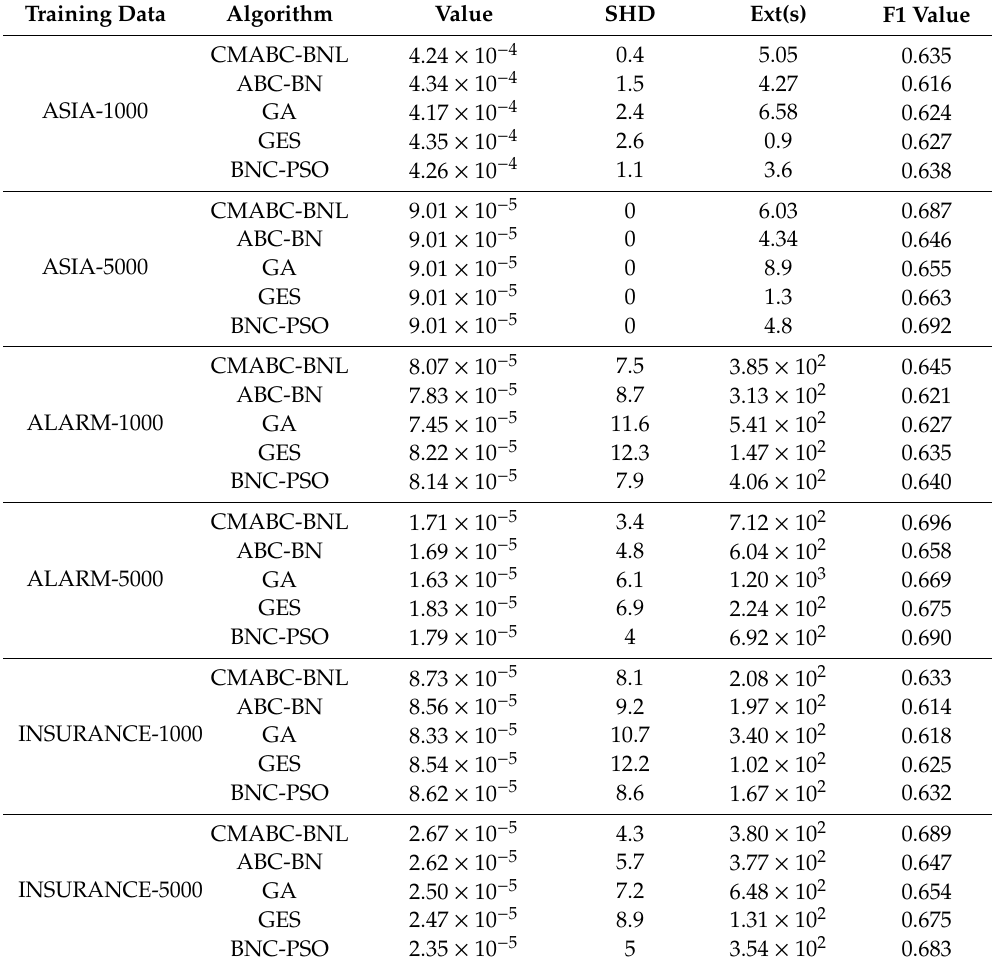
Table 4. Experimental